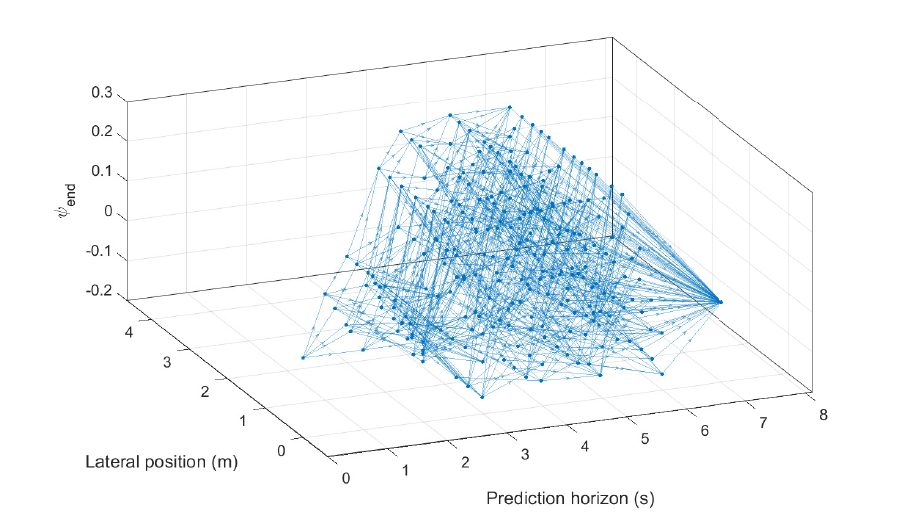
Figure 5. Recalculated graph for the motion-planning